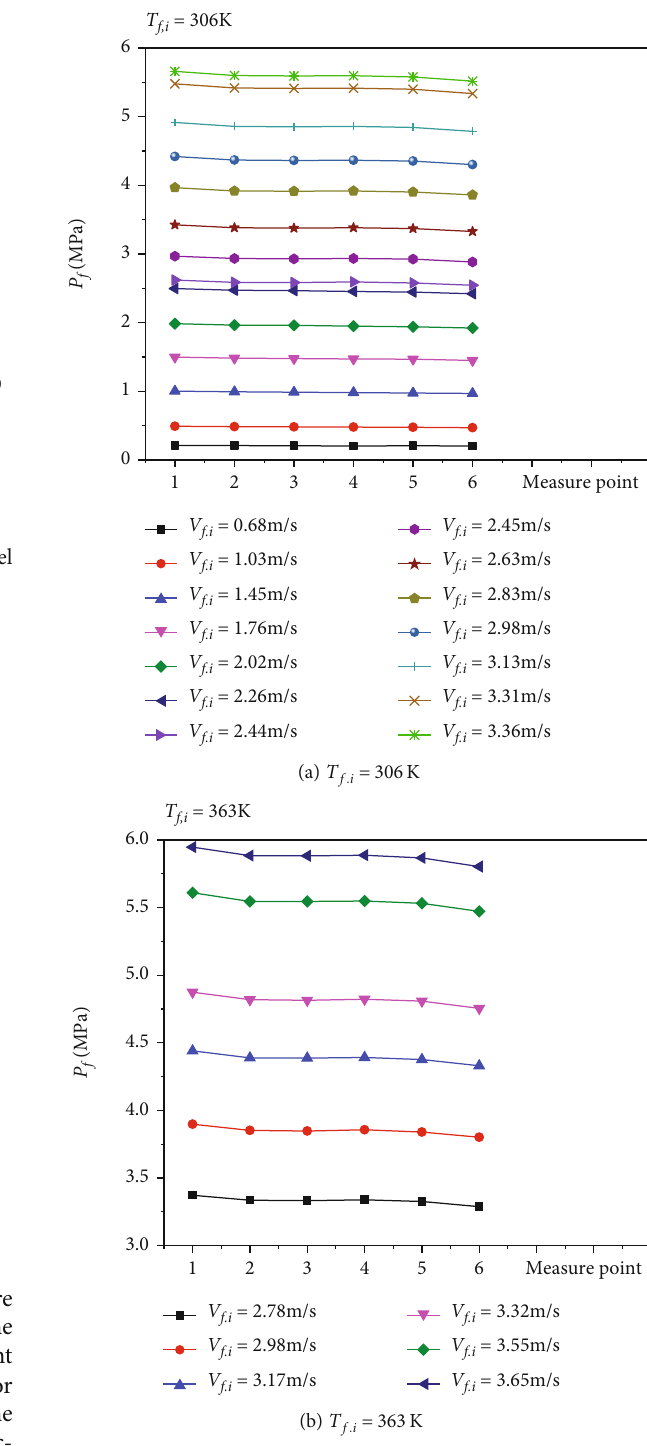
Figure 16: Pressure distribution of pilot